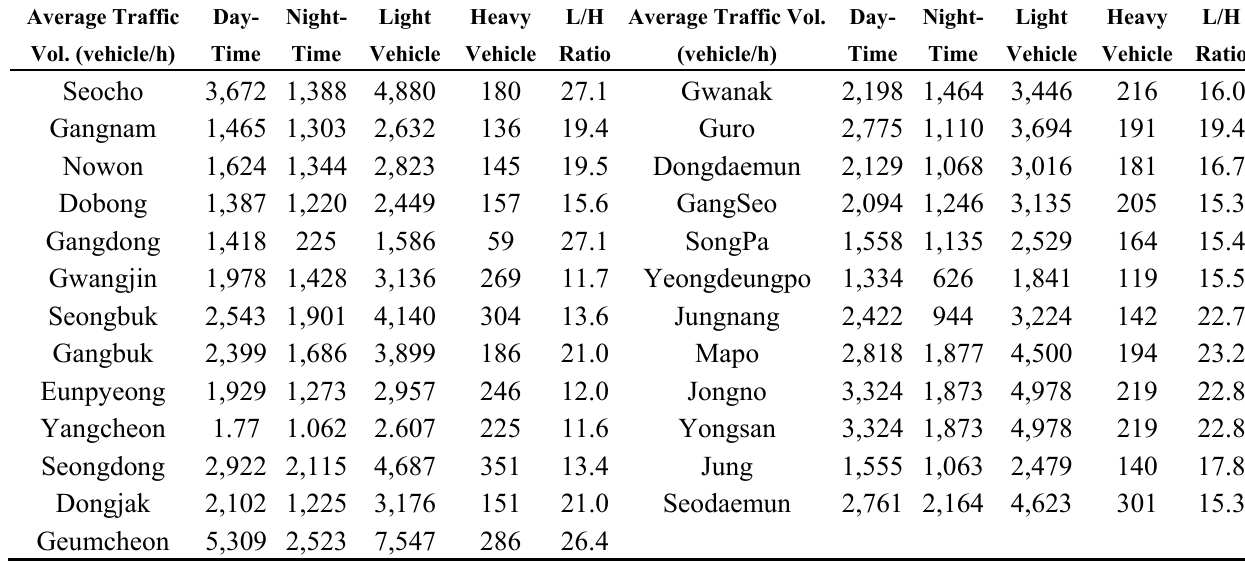
Table 1. Summary of traffic data for 25 districts of